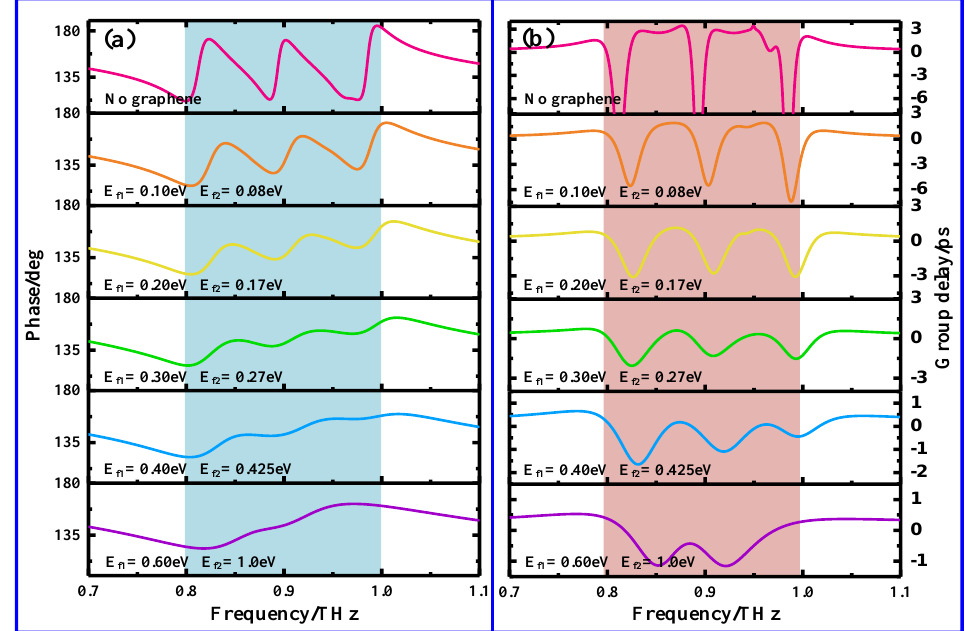
Figure 7. Reflection phase shift ( a ) and group delay ( b ) of the proposed graphene-functionalized MS with different E f1 and E f2 .